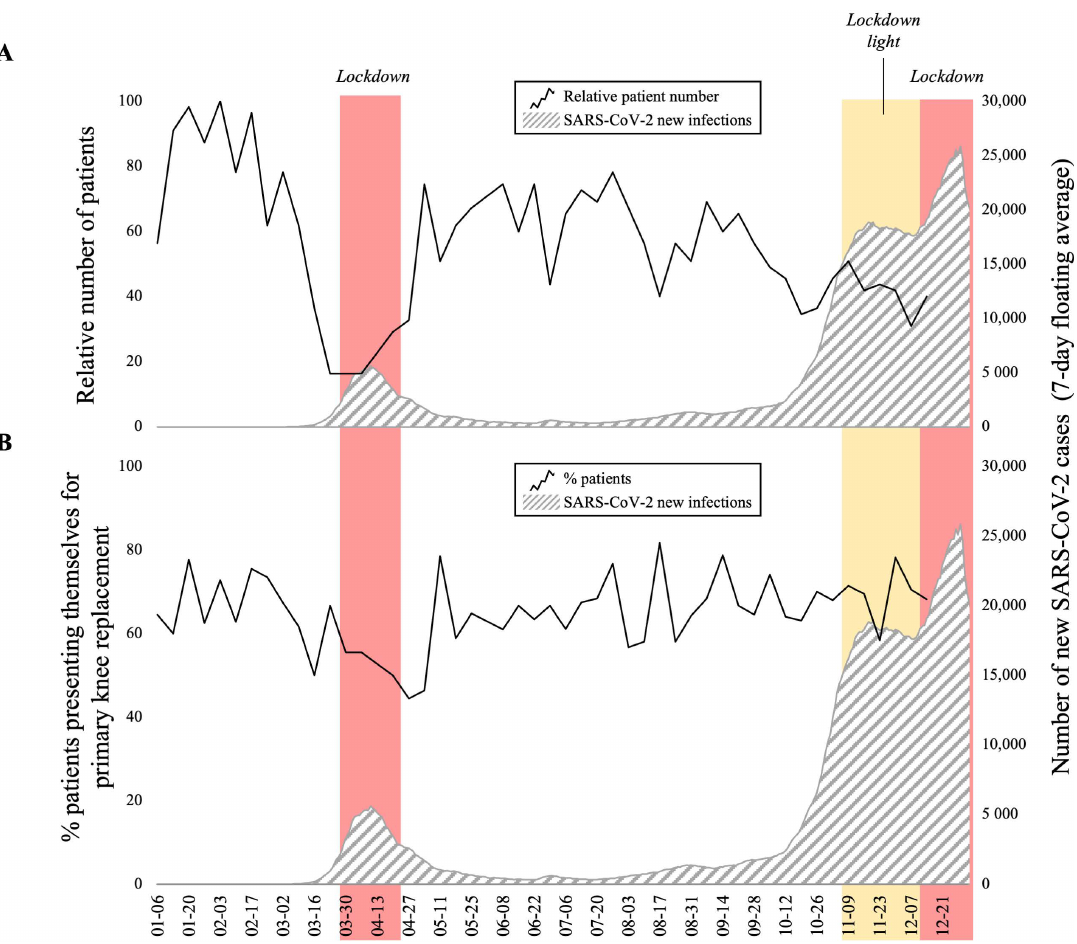
Figure 4. ( A ) Relative patient numbers (black curve) referred to our outpatient department and number of new SARS-CoV-2 infections (grey, striped area). ( B ) Percentage of patients with knee osteoarthritis to assess clinical indications for primary knee replacement in our outpatient department.